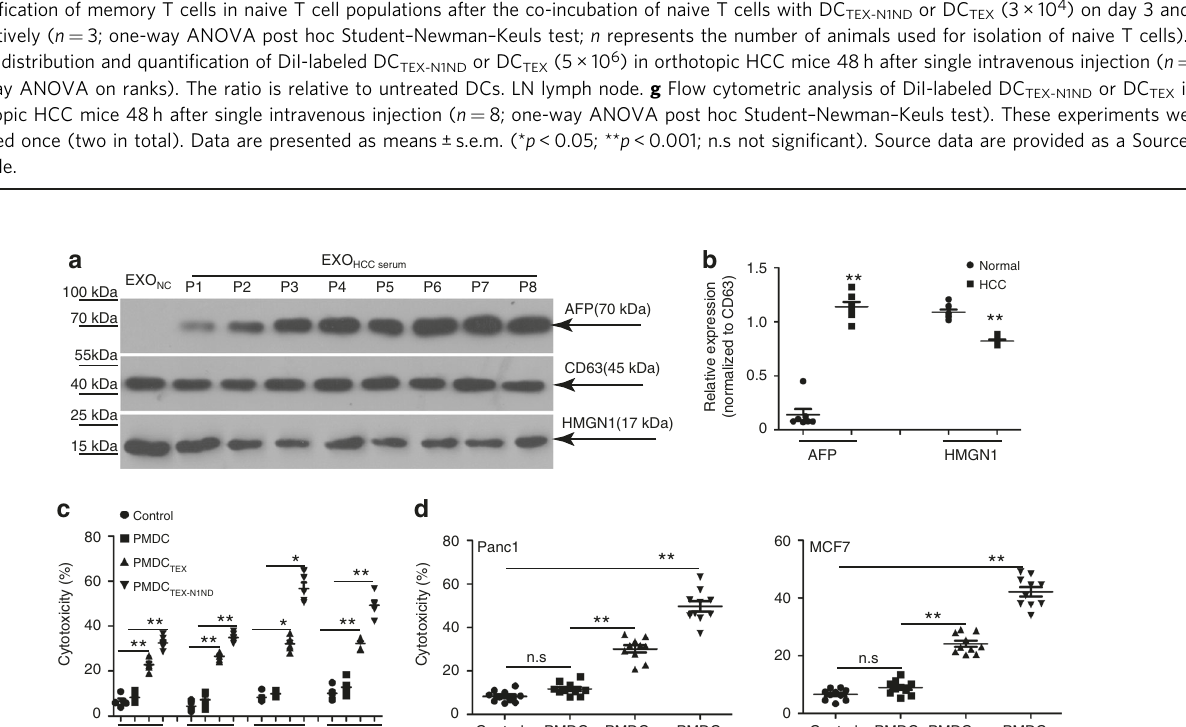
Fig. 6 Effect of DC TEX-N1ND on T cells from DC TEX-N1ND -immunized mice. C57BL/6 mice were immunized with DC TEX-N1ND (2 × 10 6 cells once per week for 3 weeks) and splenic memory or naive T cells were isolated from immunized mice 4 weeks after last immunization. a Quanti fi cation of T CM and T EM cells in T CM cell populations after the co-incubation of T CM cells with DC TEX-N1ND or DC TEX (3 × 10 4 ) for 3 days ( n = 3; one-way ANOVA post hoc Student – Newman – Keuls test; n represents the number of animals immunized with DC TEX-N1ND ). b Levels of IFN- γ and IL-2 in the culture medium after the